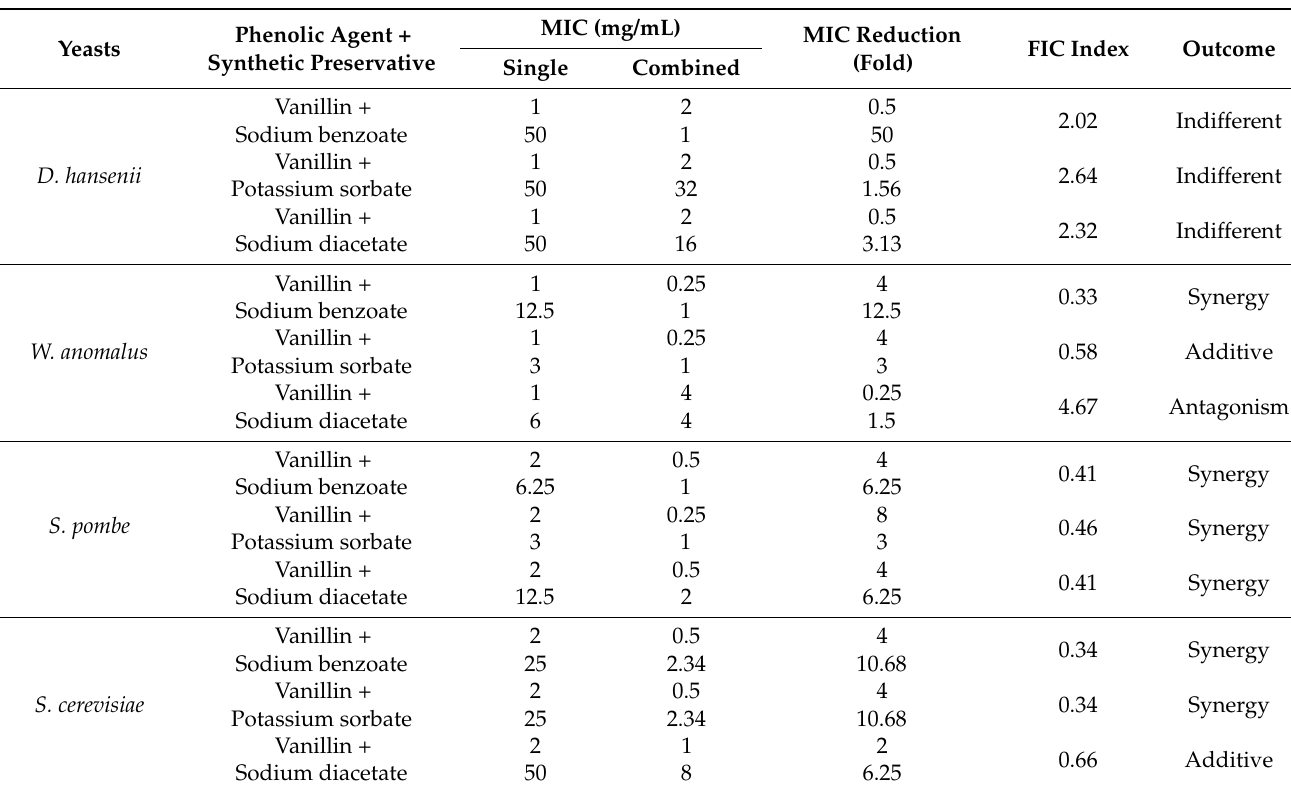
Table 2. Effect of combination of vanillin and synthetic preservatives on planktonic growth of food spoilage